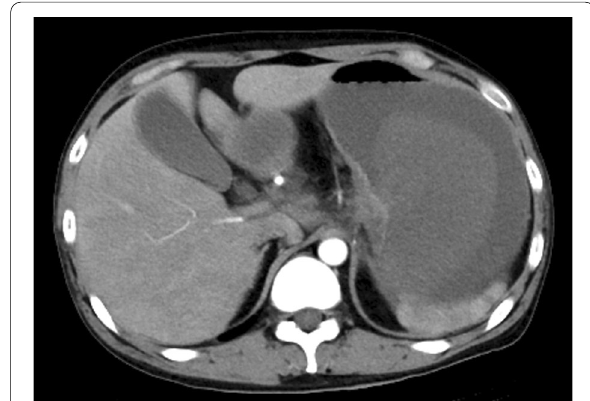
Fig. 1 Dynamic computed tomography (CT) shows a massive, contrast-enhanced fluid collection in the stomach